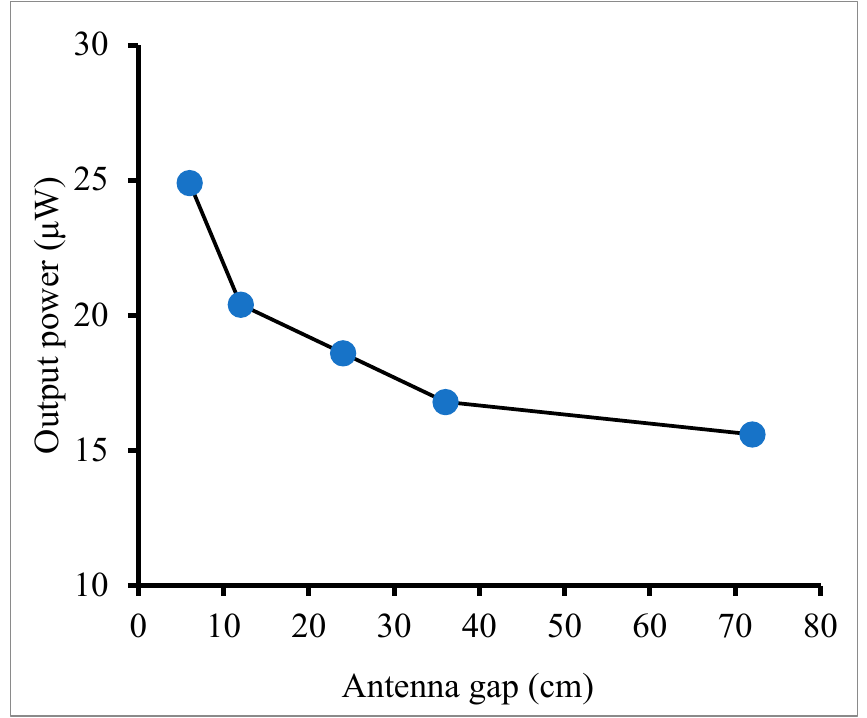
Figure 5. Output power with the antenna gaps. Other parameters were constant. The speed of air was around 4 m/s, temperature was 32 °C, gross area of each antenna was 72 × 72 cm 2 , and the wire diameter was 2.5 mm.